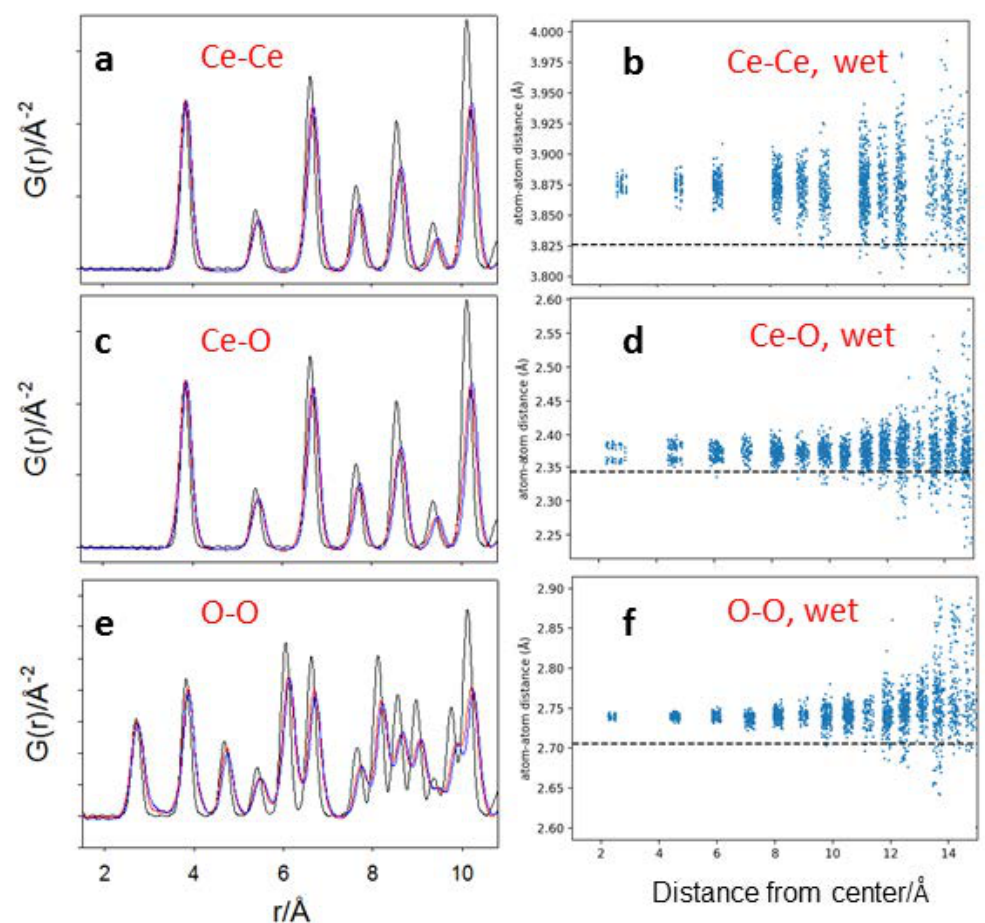
Figure 10. ( a , c , e ) Force field computed Ce–Ce, Ce–O and O–O partial PDFs, respectively. The colors of panels ( c , d ) are the same as Figure 9. The right-hand panels report the shortest Ce–Ce ( b ), Ce-O ( d ) and O–O ( f ) distances as a function of the distance of the couples of atoms from the center of the wet nanoparticle. Dashed black lines indicate the optimized Ce–Ce, Ce–O and O–O distances for relaxed bulk CeO 2 .